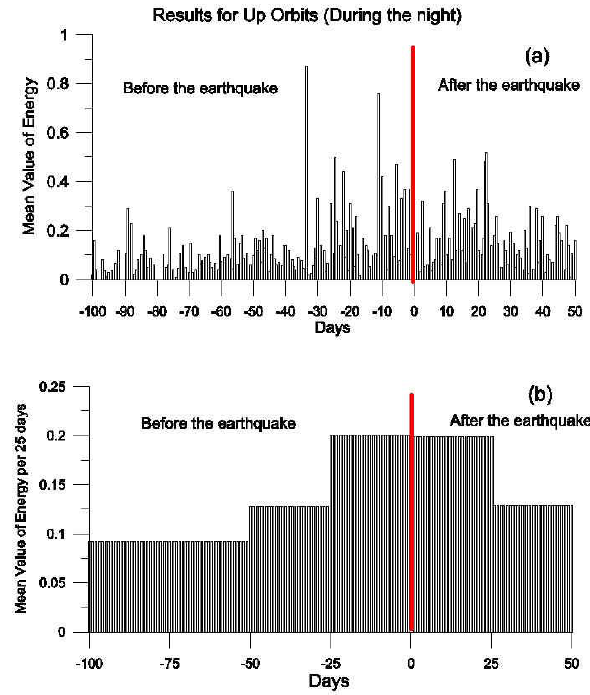
Fig. 6. Results of the mean value of energy per 25 days for the Fig. 7. (a) The average energy of the pre-earthquake signals Figure 6. Results of the mean value of energy per 25 days for the pre-earthquake pre-earthquake signals recorded by the DEMETER satellite during signals that are recorded by the DEMETER satellite during night (Fig. 6a) and day recorded by the satellite during night-passing for 100 days before night (a) and day passing (b) over Haiti. In both figures, the energy Figure 7. a) The average energy of the pre-earthquake signals recorded by the satellite passing (Fig. 6b) over Haiti. In both figures, the energy of the pre-earthquake signals the main earthquake as well as for the aftershock signals for 50 days. of the pre-earthquake signals increases at the same rate regarding during night-passing, for 100 days before the main earthquake as well as for the increases at the same rate regarding the time before the earthquake. (b) The average energy per 25 days of the observed signal during the same time period before the earthquake. aftershock signals for 50 days. b) The average energy per 25 days of the observed the night, for 100 days before and 50 days after the signal during the night, for 100 days before and 50 days after the earthquake.